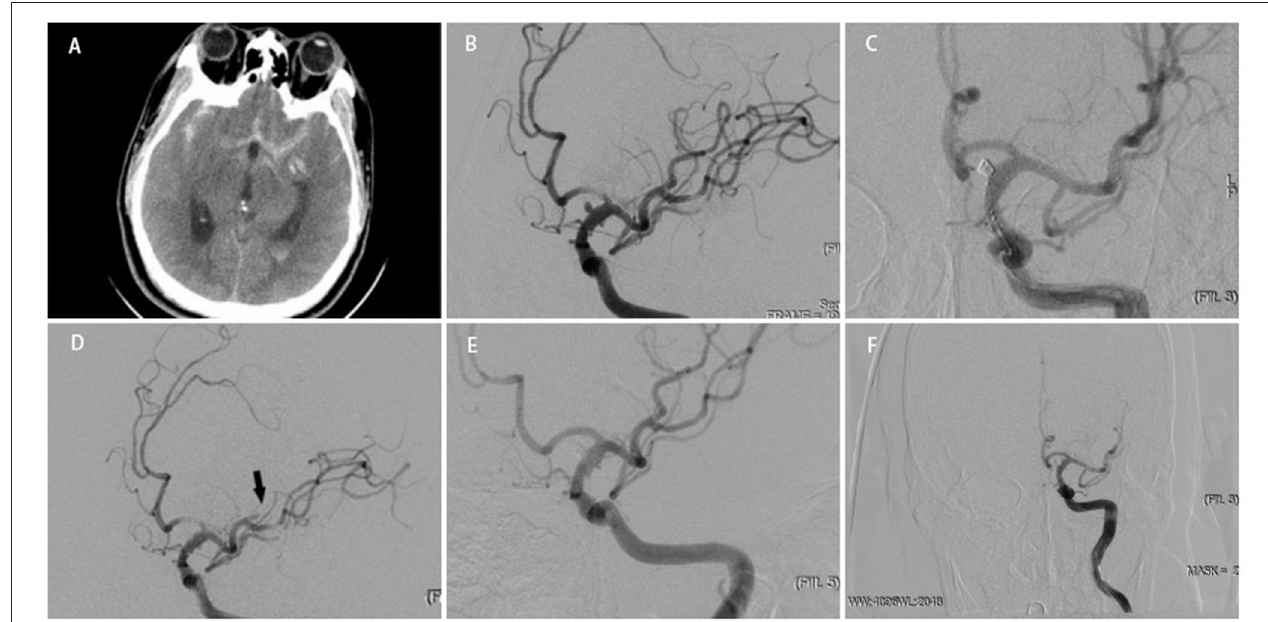
FIGURE 1 | A middle-aged person was admitted to our hospital for sudden headache 10h earlier (H-H grade 3). An emergency cranial CT revealed diffuse subarachnoid hemorrhage (A). Cerebral angiography at different angles showed a BBA located at the side wall of the C7 segment of right ICA. Multiple stents + coils got the nod to protecting anterior choroidal artery and posterior communicating artery from acute occlusion (B). Two LVIS stents (LVIS 4.5 * 20mm) combined with coiling were delivered and deployed successfully, and the instant angiographic result revealed no contrast filling into the aneurysm (C). Intraoperative angiographic revealed that a branch of MCA occluded(black arrow) (D). After tirofiban injection, angiographic revealed the reappearance of MCA branch and total occlusion of the aneurysm (E). Angiographic follow-up at 5 months revealed total occlusion of the aneurysm (F) .